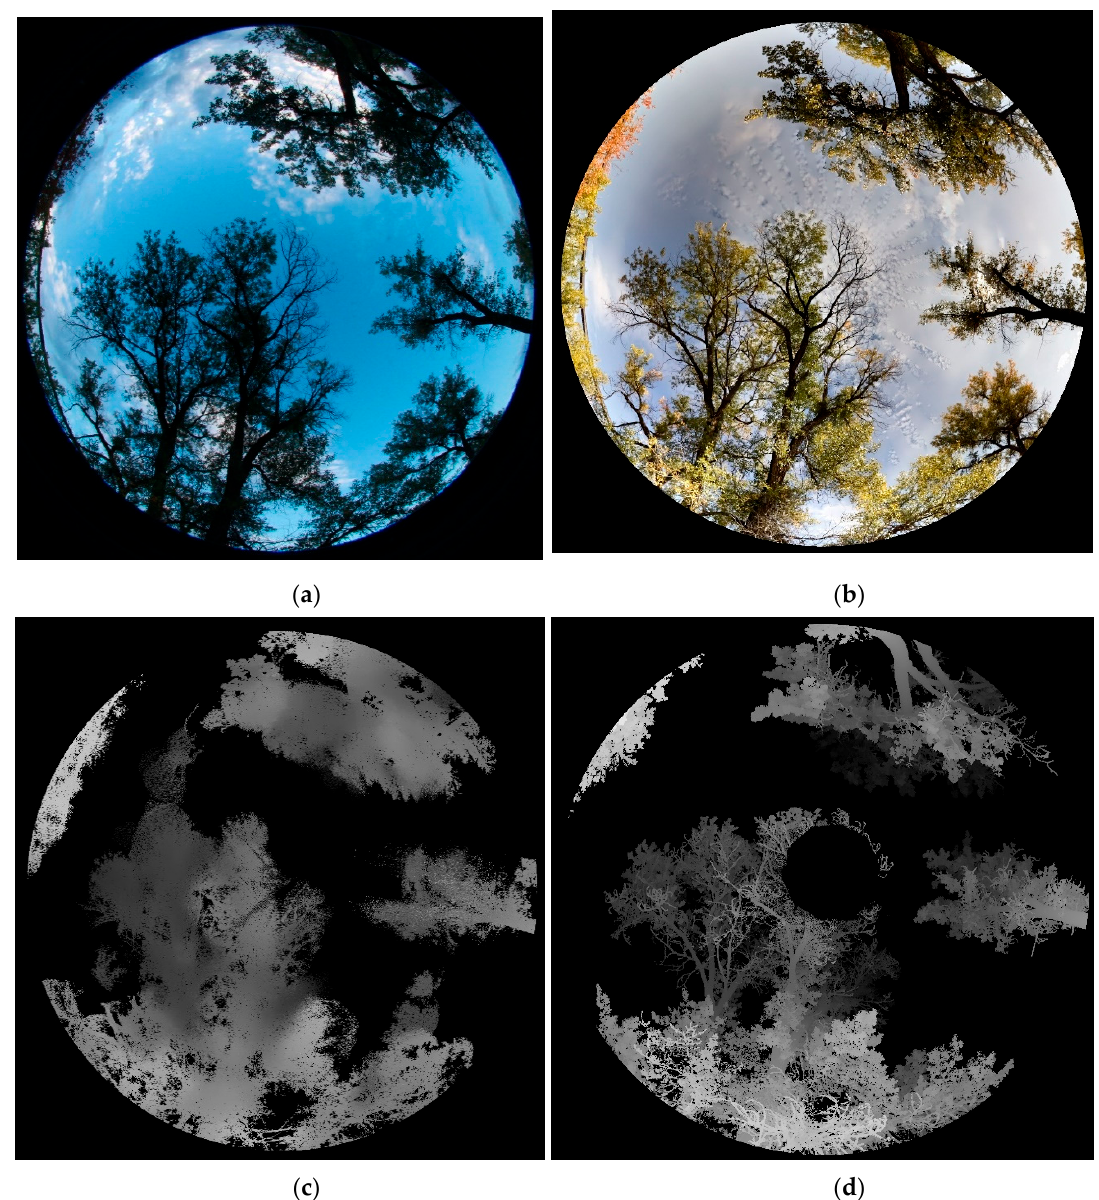
Figure 11. Fisheye-view images compiled from the September 9th datasets based on ( a ) DHP, ( b ) FSS, ( c ) FSS depth, and ( d ) TLS depth.